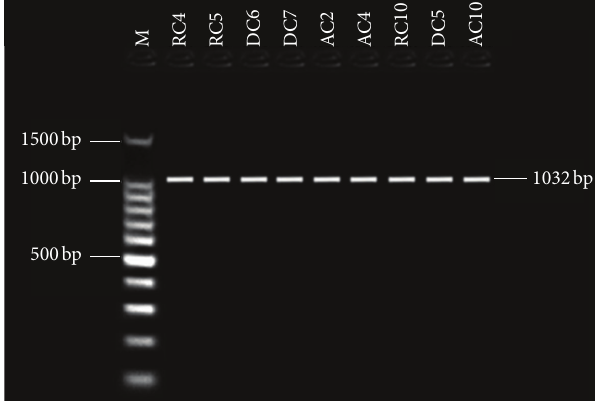
Figure 5: Gel electrophoresis analysis PCR products using omt-1 primer with 797 bp, lanes from RC4 to AC4 ( A. flavus ), lanes from RC10 to AC10 ( A. parasiticus ), and lane M: 100bp DNA ladder size